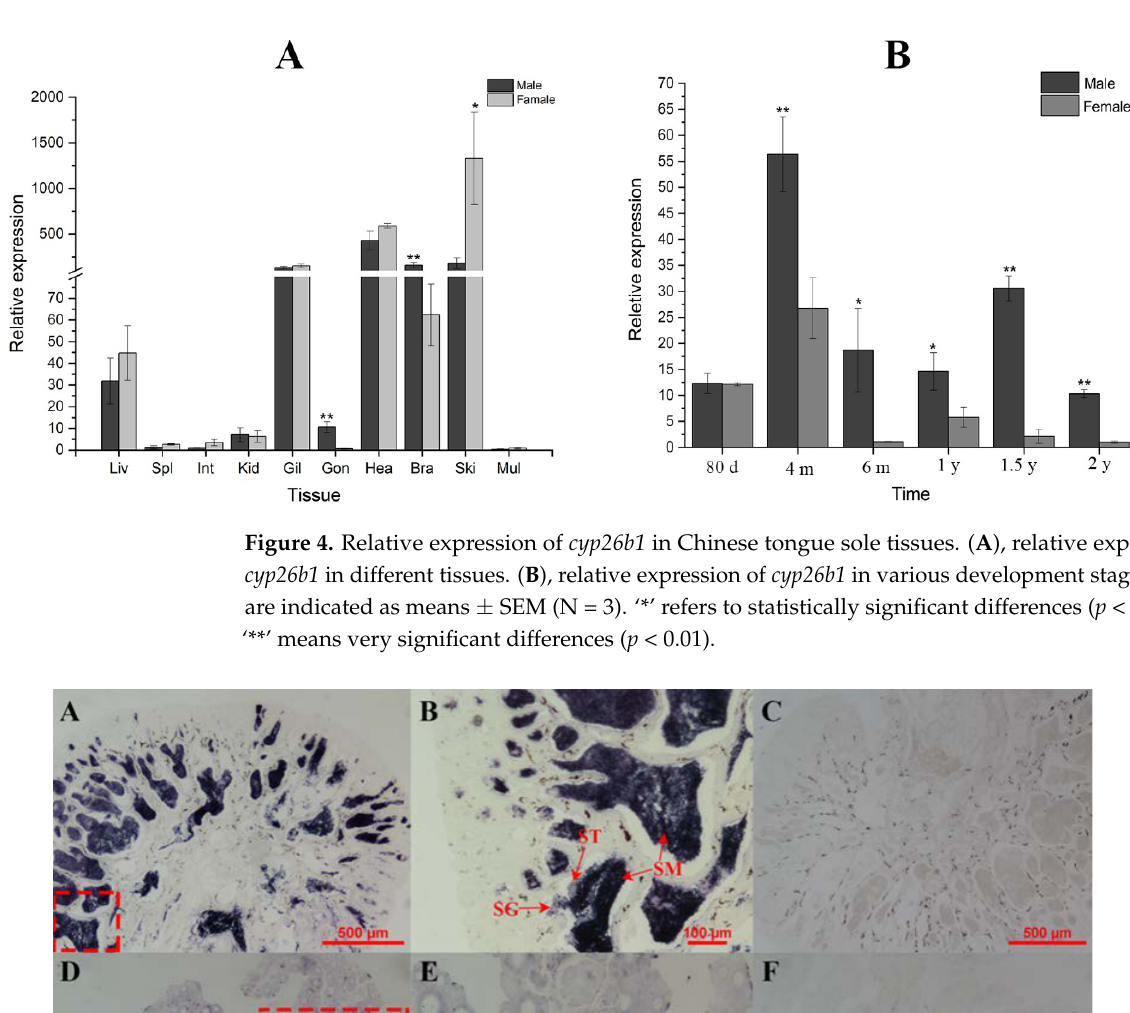
Figure 5. Cellular regionalization of cyp26b1 mRNA in 2 yph gonads of Chinese tongue sole. In situ hybridization of gonads by means of antisense ( A , B , D , E ) and sense ( C , F ) probes of cyp26b1 mRNA performed in Chinese tongue sole. ( B ) High magnification of the red-framed space in ( A ). ( E ) a high magnification of the red-framed space in ( D ). SG: spermatogonia; ST: spermatid; SM: sperm; I: Stage I oocytes; II: Stage II oocytes; III: Stage III oocytes; IV: Stage IV oocytes. Scale bar is shown in the figures.